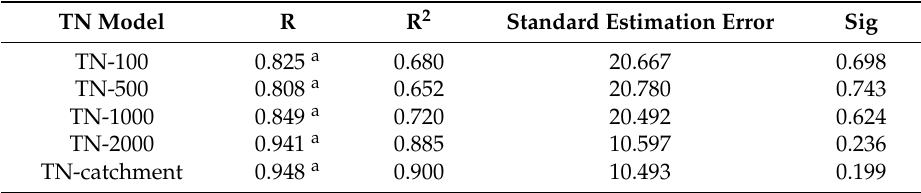
Table 14. The linear model general situation of